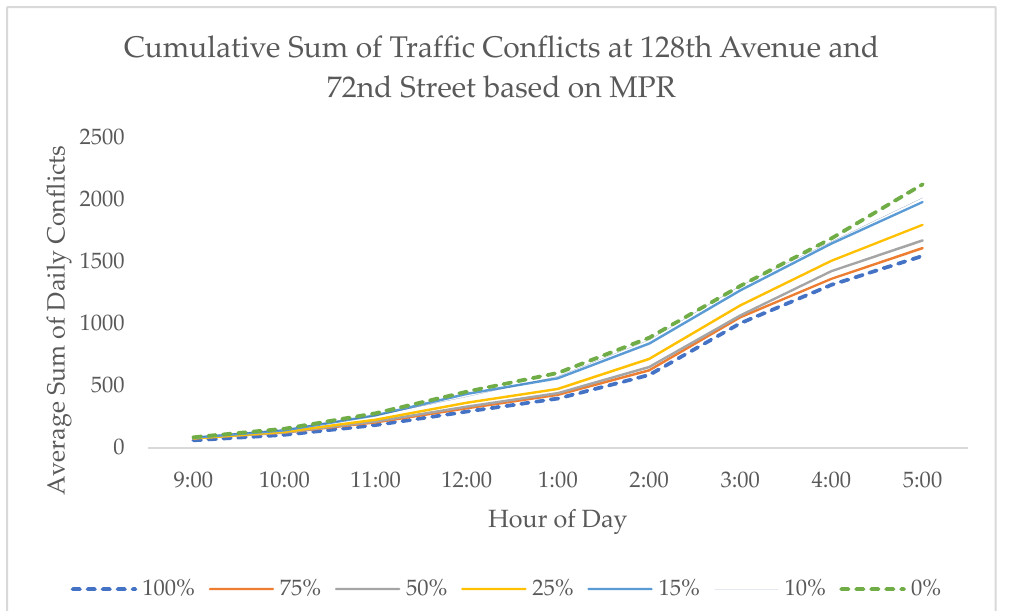
Figure 7. Variation of conflict rate per hour on 128th Street and 72nd Avenue.